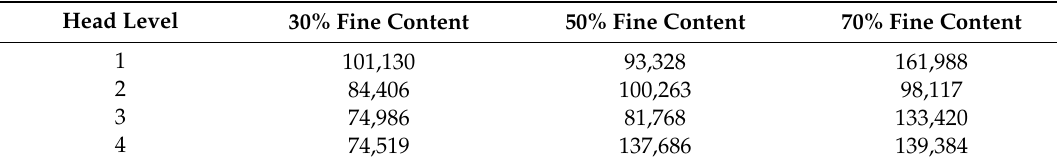
Table 19. Fine particle content change during seepage (0–10 µ m).